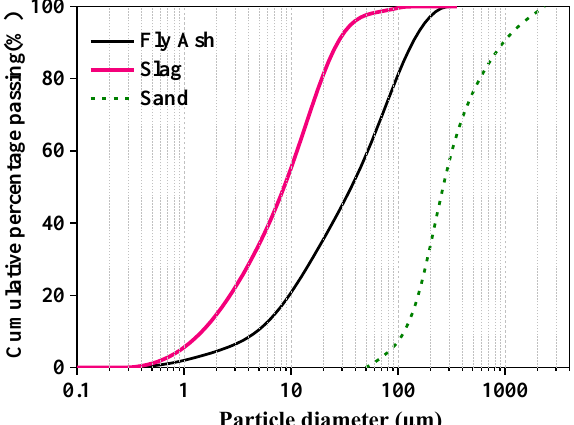
Figure 1. Particle size distributions of powder materials. Table 2. Mix proportions of the AAFS